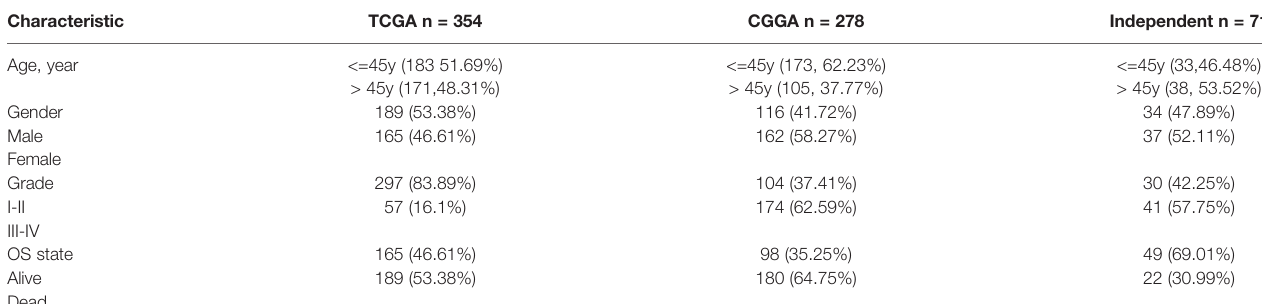
TABLE 2 | Analysis of the clinical characteristics of patients from multiple institutions.